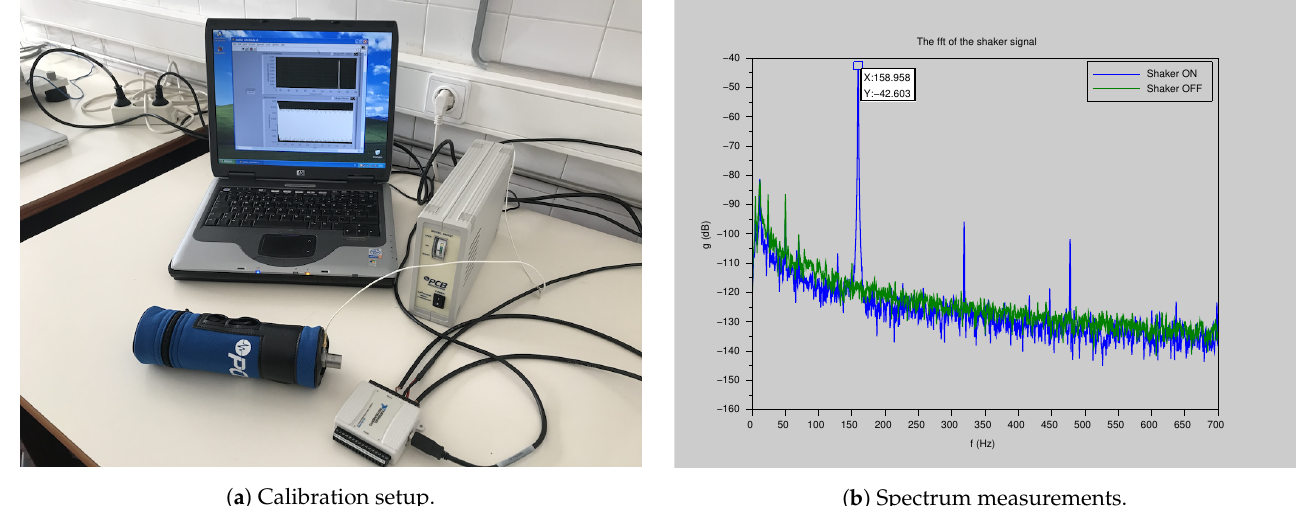
Figure 7. Accelerometer calibration setup and spectral